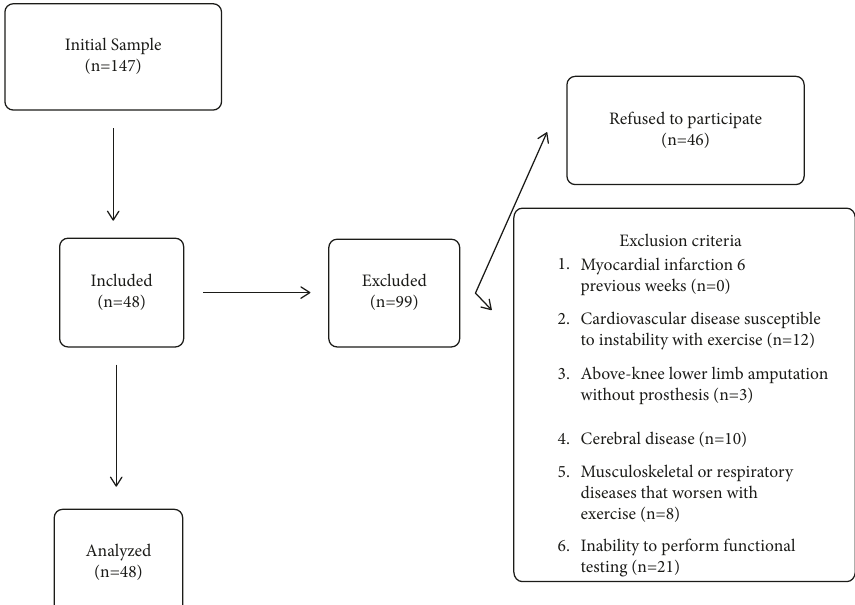
Figure 2: Participant flow